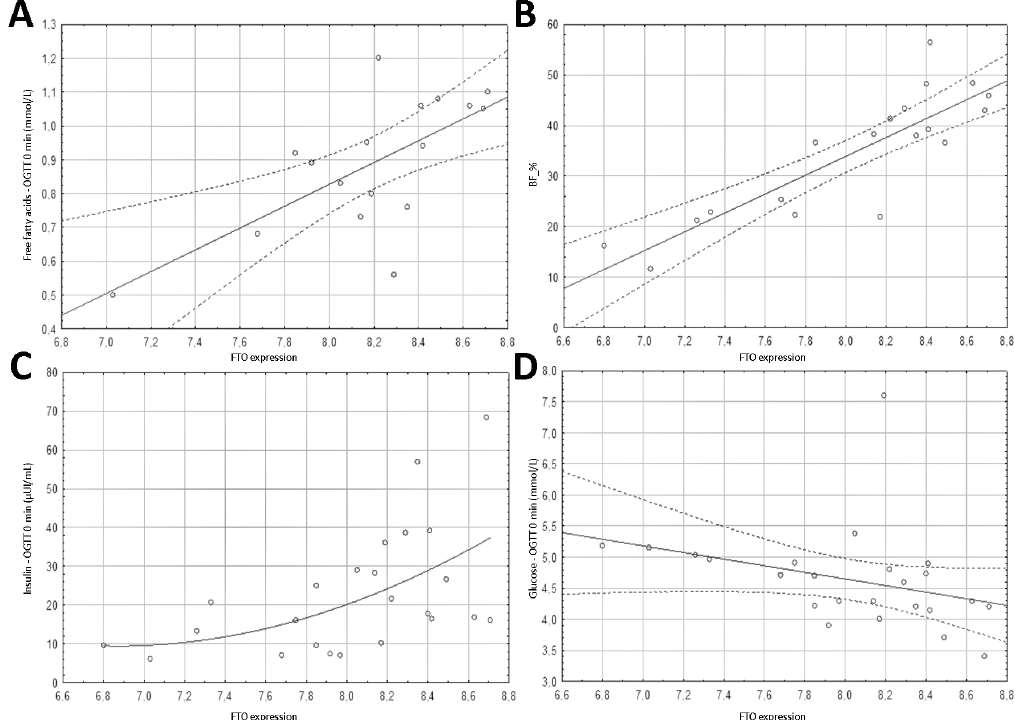
Figure 2. Plots presenting the distribution of data of the studied parameters depending on the level of FTO expression (shown as log 2 of the absolute value of the expression for clarity of the plot). ( A ) Free fatty acids—OGTT 0 min (mmol/L); ( B ) BF_%; ( C ) insulin—OGTT 0 min (µIU/mL); ( D ) glucose—OGTT 0 min (mmol/L).